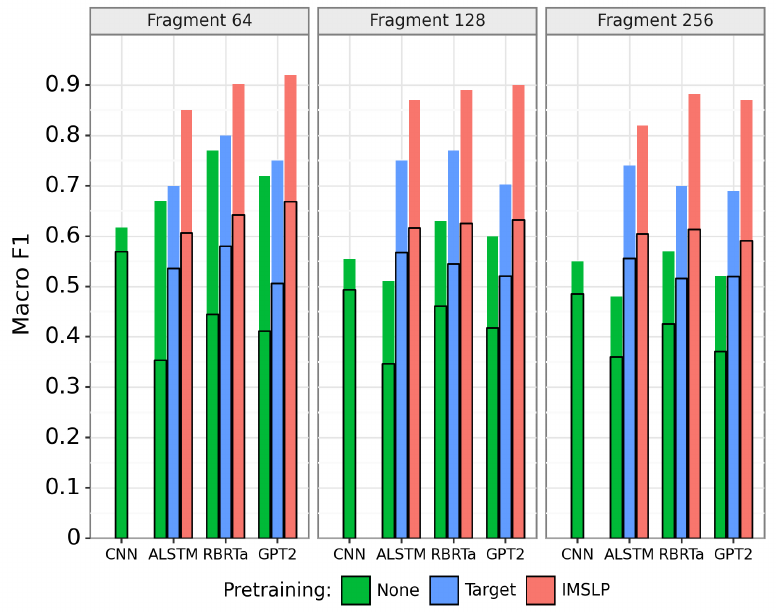
Figure 5. Results on the full-page classification task. For each model architecture, the green (leftmost), blue (center), and red (rightmost) bars show the performance with no pretraining, target pretraining, and full IMSLP pretraining, respectively. Colored bars indicate performance with both training and test time data augmentation ( K = 3, L = 2), and black rectangles indicate performance without augmentation ( K = 0, L =